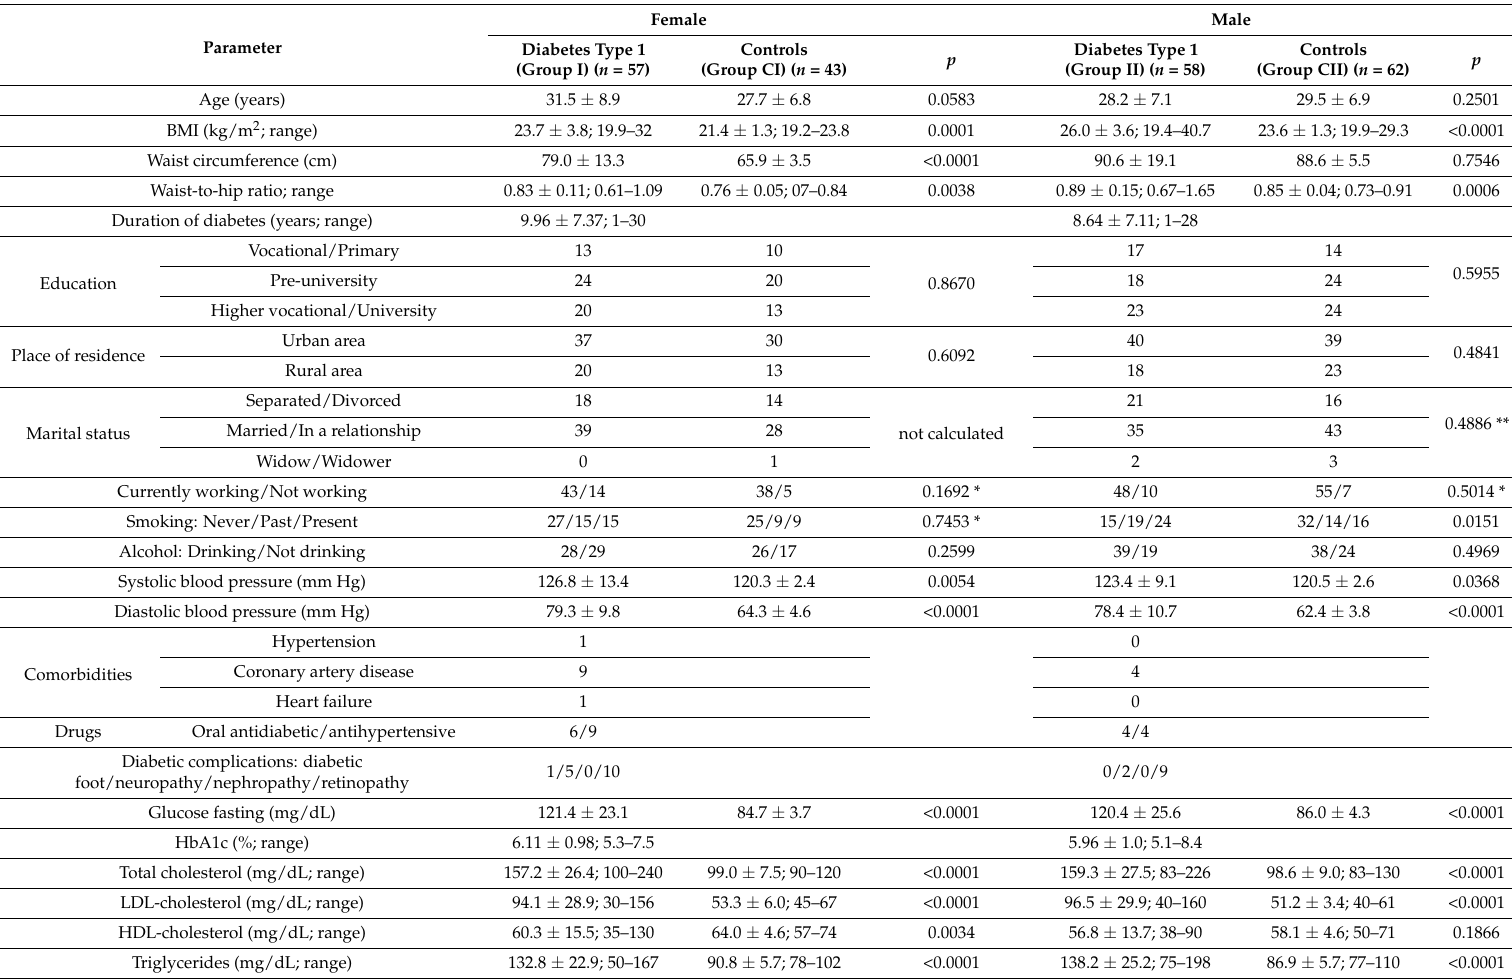
Table 1. Sociodemographic, clinical, and biochemical characteristics of the studied